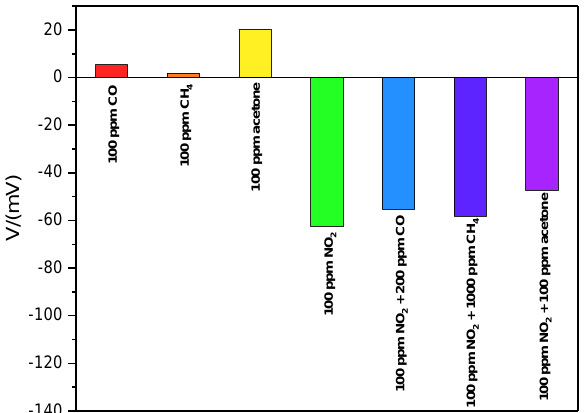
Figure 9. Cross-sensitivity measurement for Sensor C to 100 ppm various gases at 250 ◦